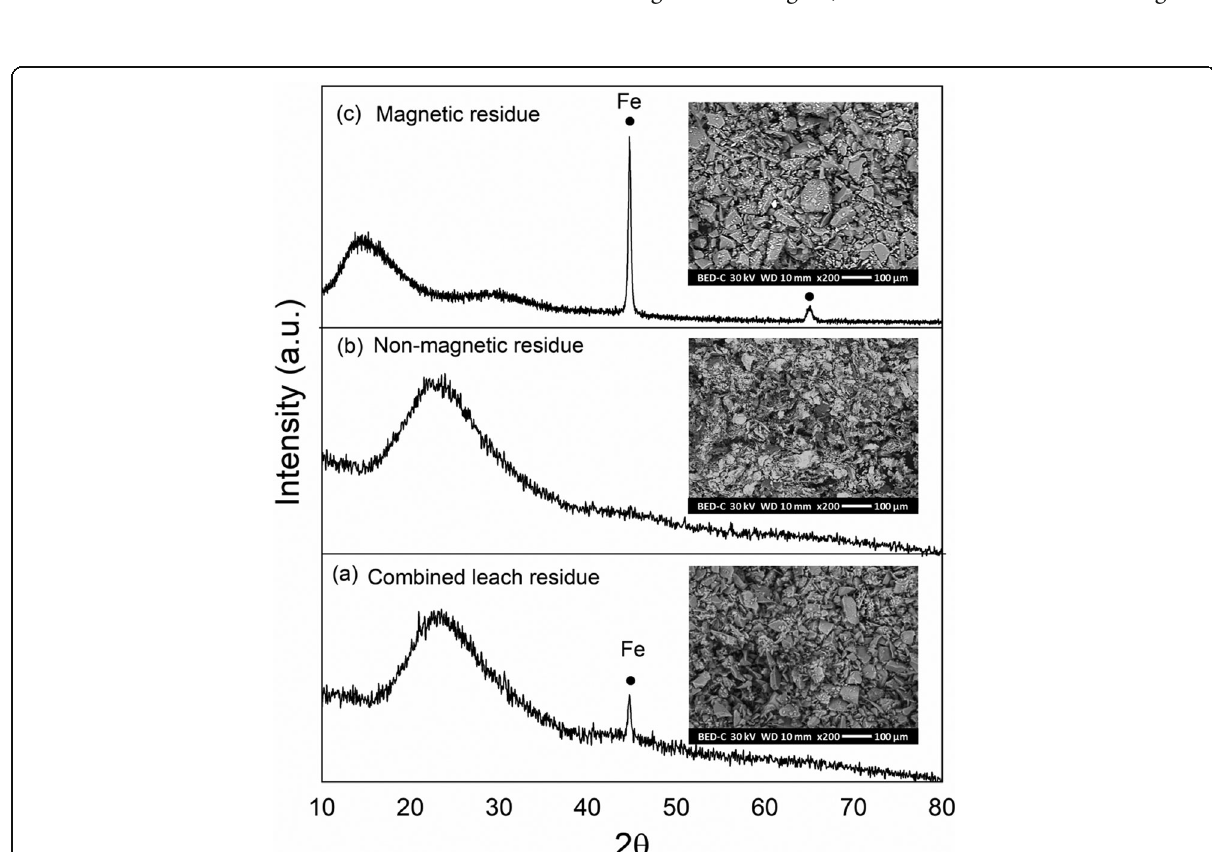
Fig. 5 XRD of different residues: ( a ) combined leached residue of LCD screen powder, submitted to ultrasonic-assisted leaching for 60 min in 0.05 M pyrophosphate solution using ultrasonic energy (US) at pH 6, ( b ) non-magnetic leach residue and ( c ) magnetic leach